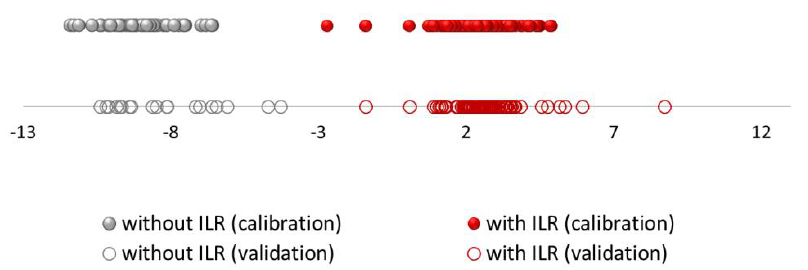
Table 1. Fisher´s linear discrimination functions for fire debris samples burned with/without IL obtained from the linear discriminant analysis (LDA).